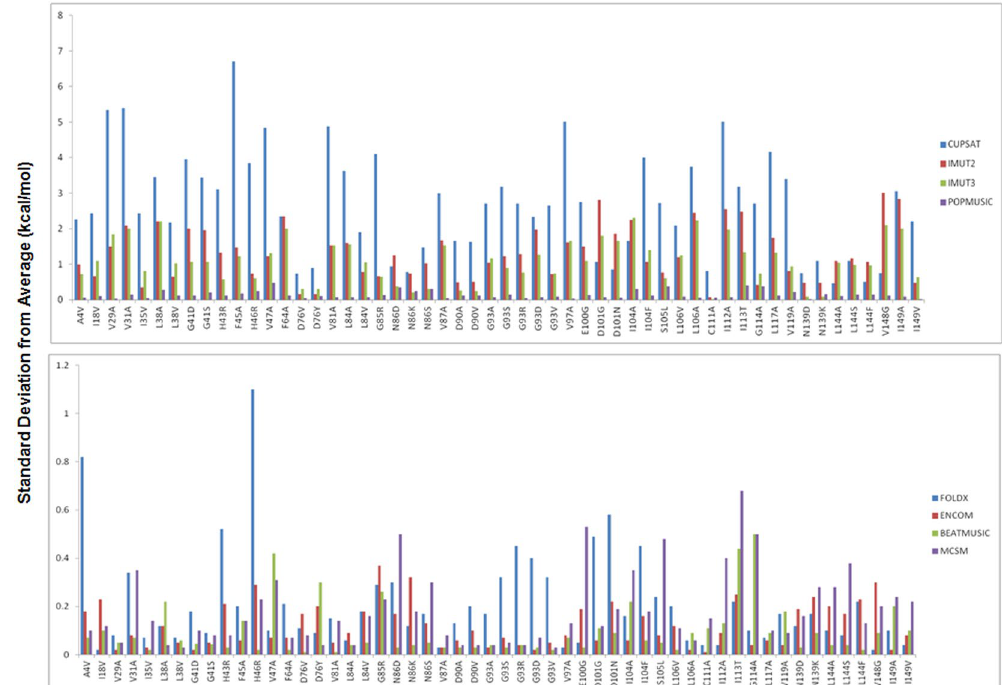
Figure 4. Structural sensitivity of methods decomposed into individual mutants (standard deviation from average result (kcal/mol) using the four structures. Top: Methods previously studied by Kepp 16 . Bottom: FoldX, ENCoM, BeatMusic, and mCSM used in this study. The total data set in Supporting Information, Tables S8 and